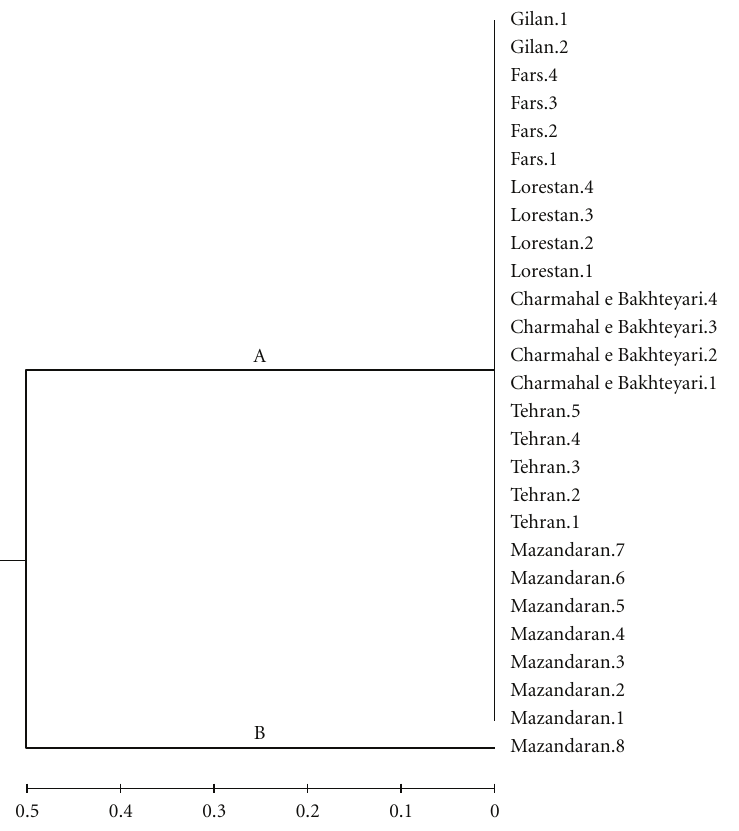
Figure 3: Phylogenetic tree of RAPD analysis of 26 isolates of S. iniae recovered from diseased trout in 6 states of Iran using UPGMA program showing one group and two